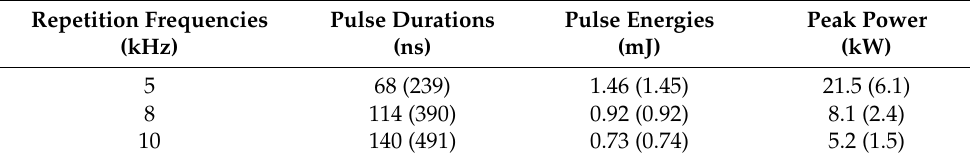
Figure 7. Simulation results for the AO Q-switched Tm:YLF laser: ( a ) pulse durations, ( b ) pulse energies and ( c ) peak powers versus incident pump powers. Table 2. Comparison of experiment and simulation results (in brackets).